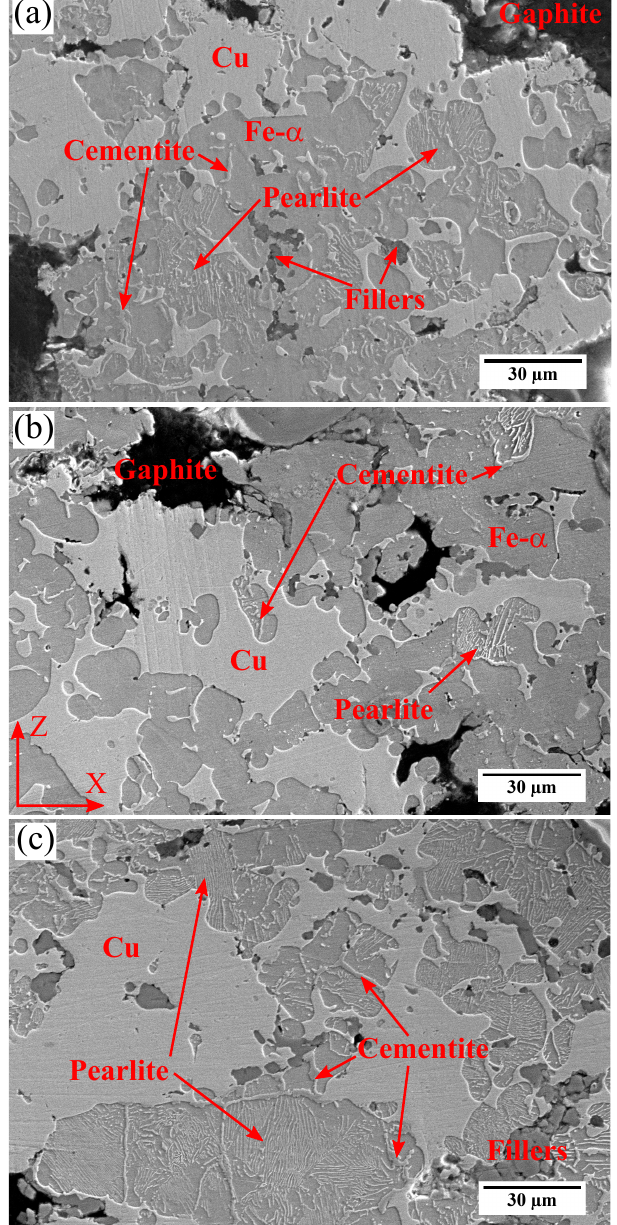
Figure 3. Secondary Electrons SE-SEM images of the ( a ) microstructure of RM material at the microscale length, ( b ) microstructure of MMCsG1 material at the microscale length, ( c ) microstructure of MMCsG2 material at the microscale